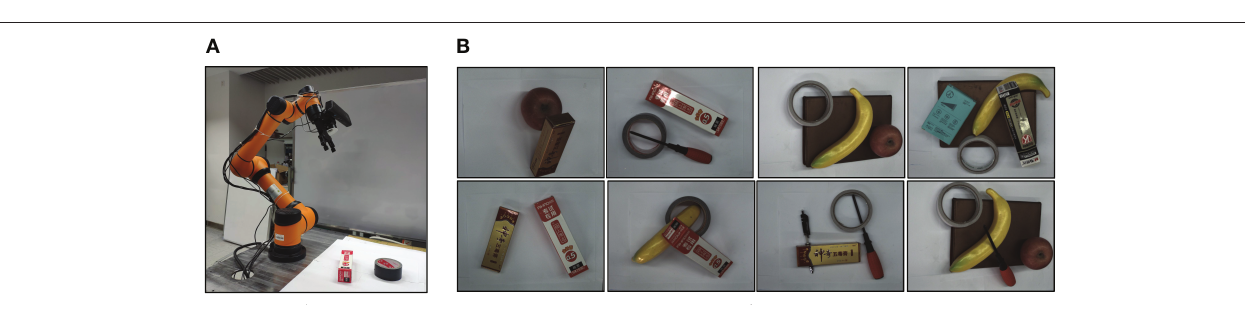
FIGURE 7 | Robot grasping experiment. (A) Robot experimental environment, and (B) some examples for grasping